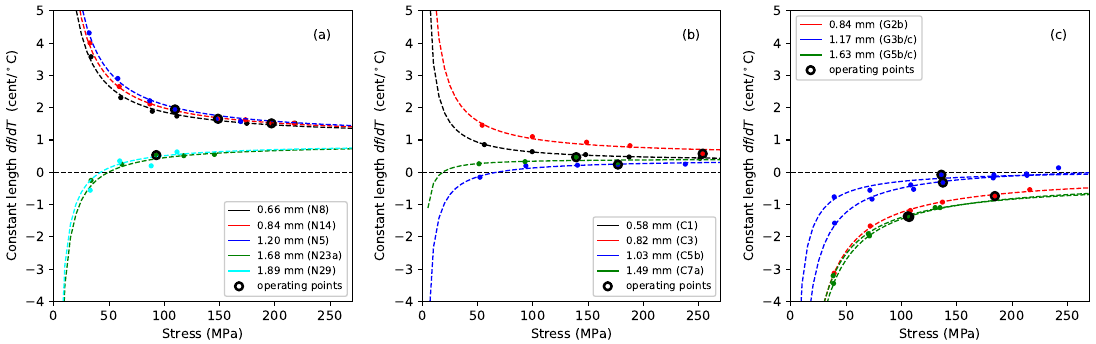
Figure7. The thermal tuning sensitivity for the strings held at constant length with no tuning adjustments, for ( a ) nylon, ( b ) fluorocarbon, and ( c ) gut. Black circles show the results at the expected operating points. The dashed lines were fitted using linear regression analysis, with 1 / stress as the explanatory